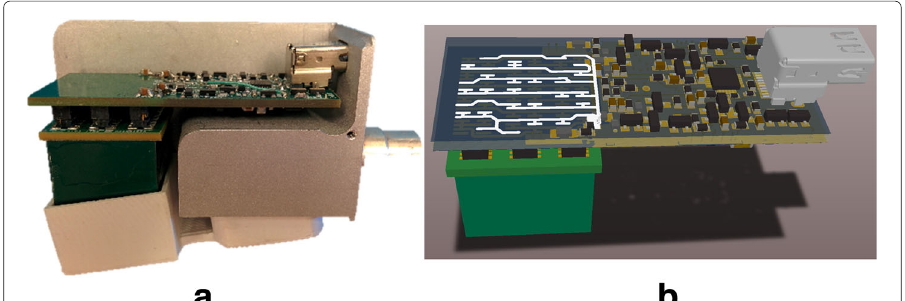
Fig. 2 a An exploded view of the detector and preamplifier assembly. The CZT crystal is shown in green while the preamp board with the Mini DisplayPort connector is on top . The 3D-printed white plastic case is also shown and is used to isolate the high-voltage cathode and physically protect the CZT crystal. b A 3D rendering of the detection module showing one layer of the PCB and conductive tracks used to make